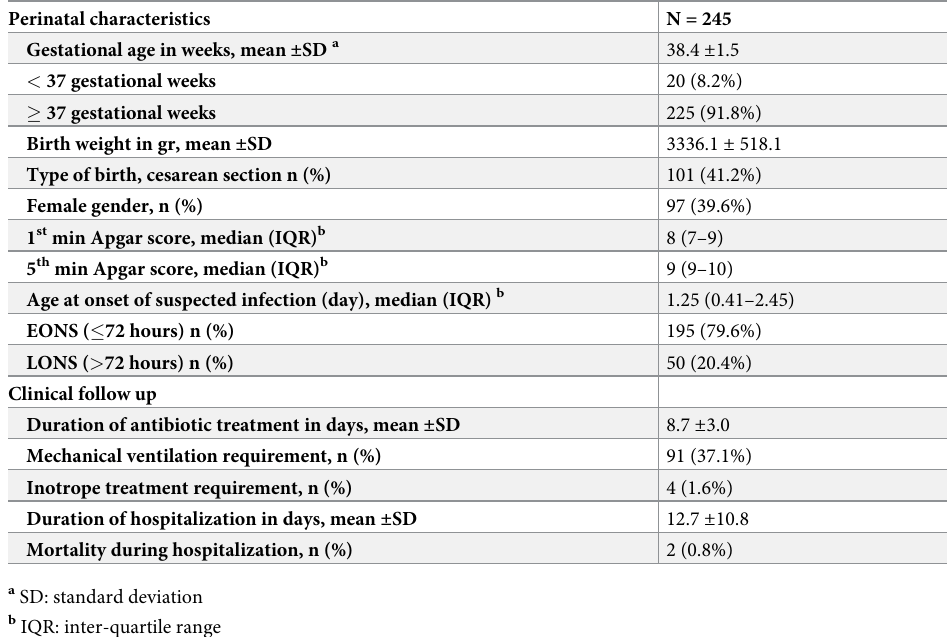
Table 1. Characteristics of the study population.